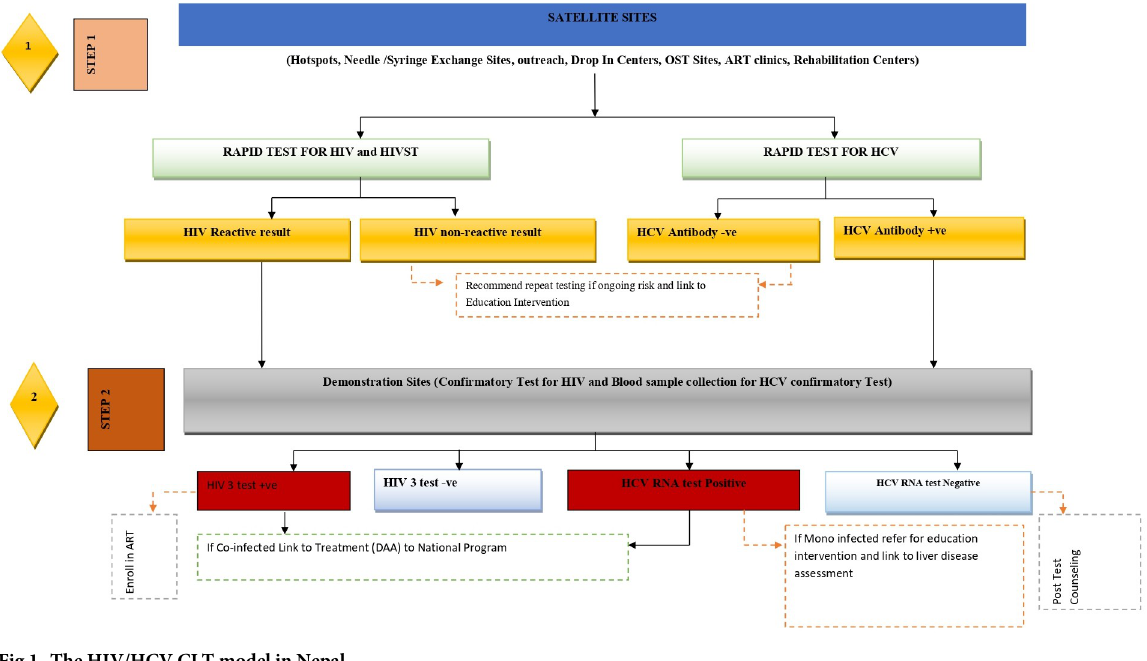
Fig 1. The HIV/HCV CLT model in